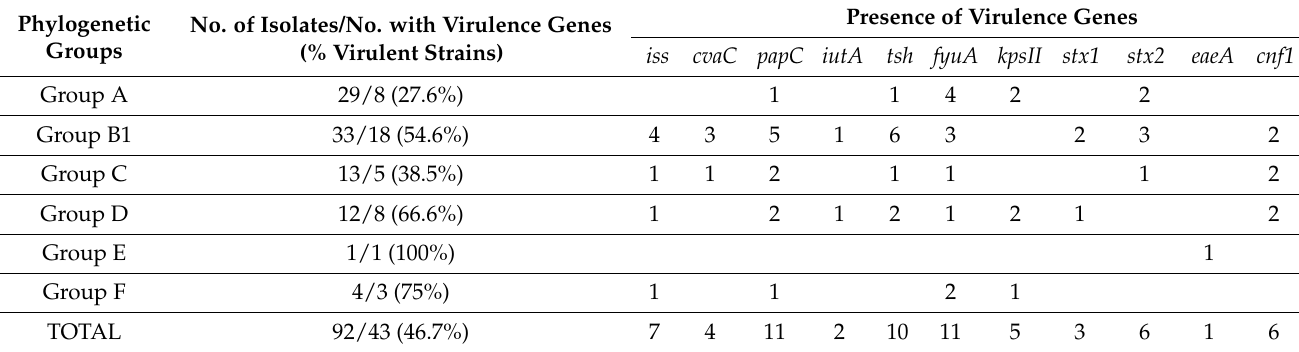
Table 3. The percentage of occurrence of virulence-related genes in various phylogenetic groups of E. coli . Phylogenetic Groups